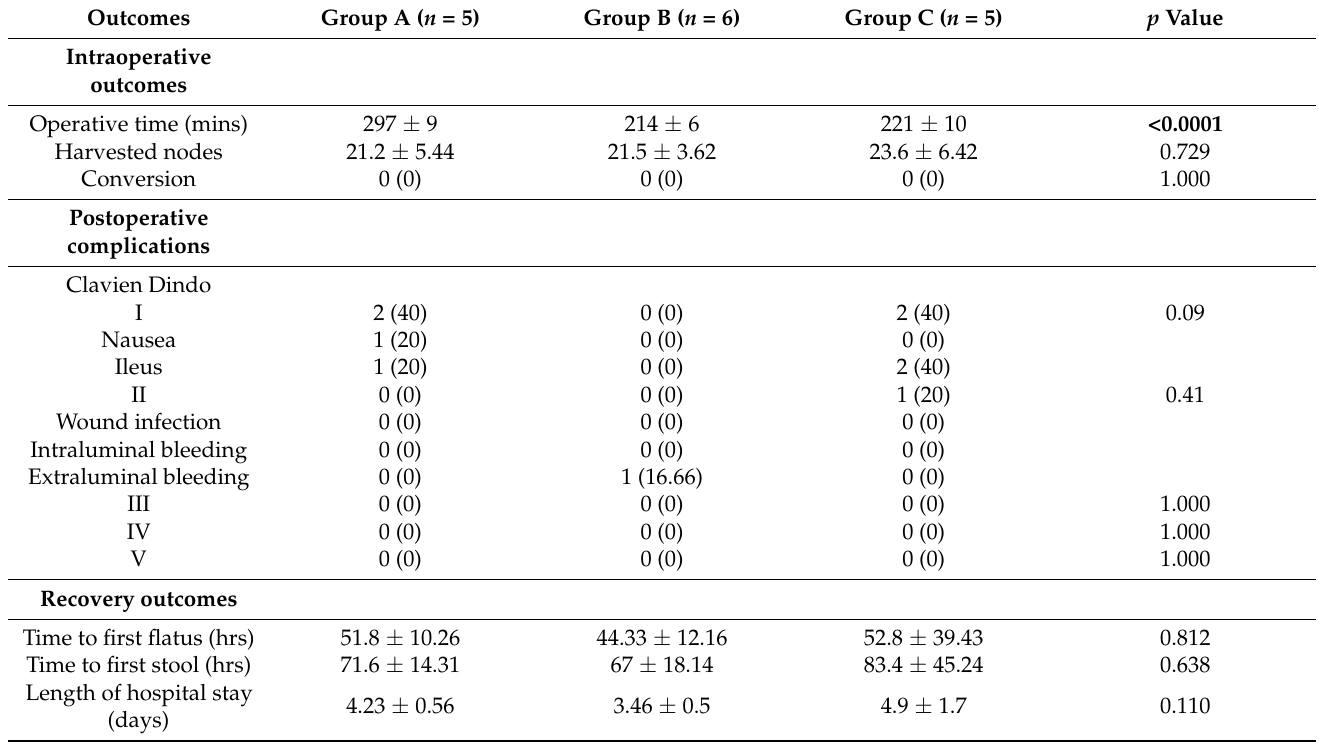
Table 5. Intraoperative outcomes, postoperative complications and recovery outcomes on rectal anterior